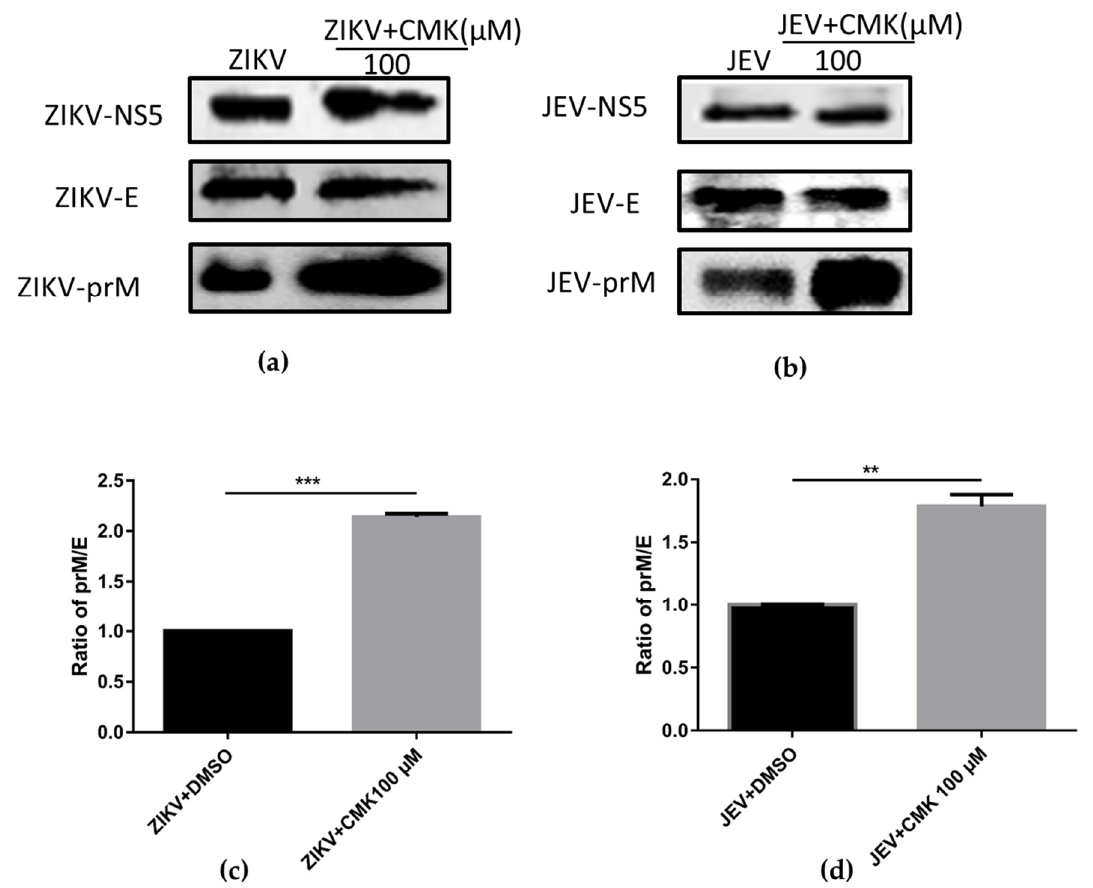
Figure 2. Dec-RVKR-cmk inhibits viral maturation process by preventing prM cleavage. Vero cells were infected with ZIKV-0.2 MOI and JEV-0.2 MOI followed by dec-RVKR-cmk treatment using 100 µ M concentration. ( a ) ZIKV and ( b ) JEV viral proteins were analyzed using SDS-PAGE at 36 hpi from the peptidyl CMK-treated and untreated infected cells and then detected by Western blotting (WB) using relevant antibodies. Quantification of E and prM proteins were analyzed by image J software and the ratio of prM / E between the dec-RVKR-cmk-treated and untreated control group was compared for both ( c ) ZIKV and ( d ) JEV.